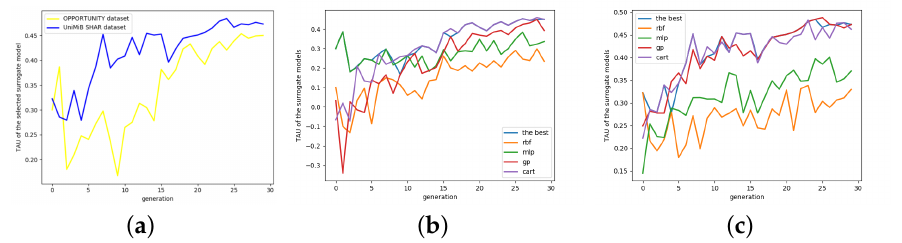
Figure 8. TAU of the different surrogate models on OPPORTUNITY and UniMiB-SHAR. ( a ) The selected surrogate model on two datasets. ( b ) OPPORTUNITY. ( c )